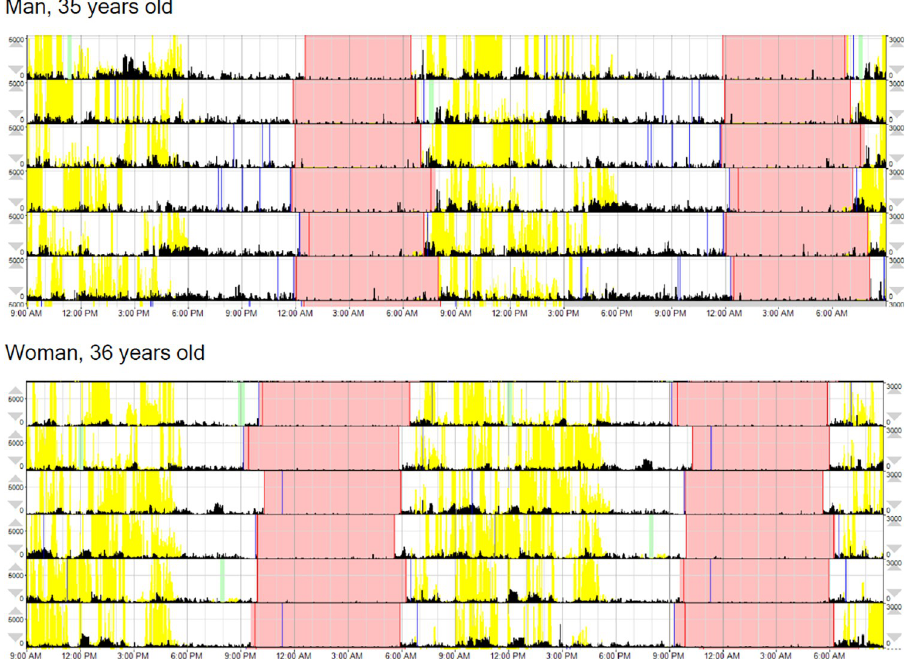
Fig 5. Actograms for a 35-year-old Maya man and a 36-year-old Maya woman. The red-shaded portions indicate sleep periods. Activity counts are shown by the black bars, and light exposure is represented by yellow. The absence of light during the night in these graphs is representative of the sample, and illustrates the light-blocking advantages of structural buffering. The graphs of men’s and women’s sleep patterns visualize the later bedtimes and waketimes of men compared to women, as well as the greater variance in sleep offset (i.e., wake)